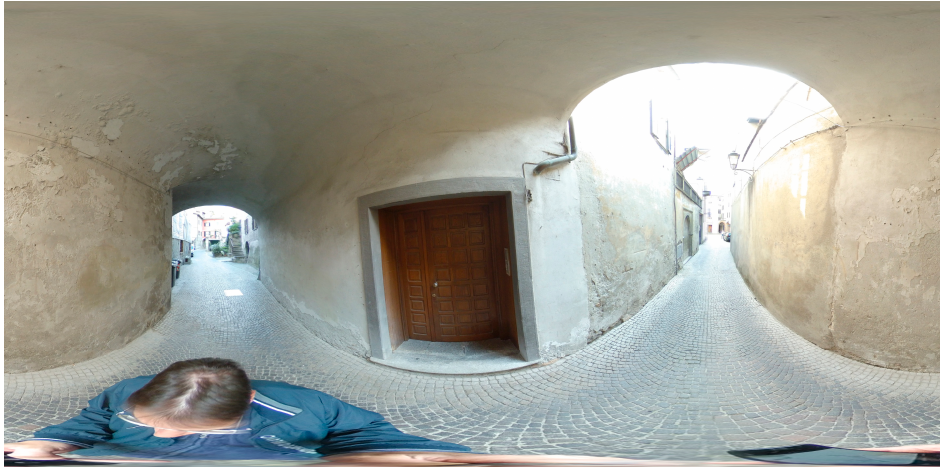
Figure 11. A single equirectangular projection acquired in the alley.